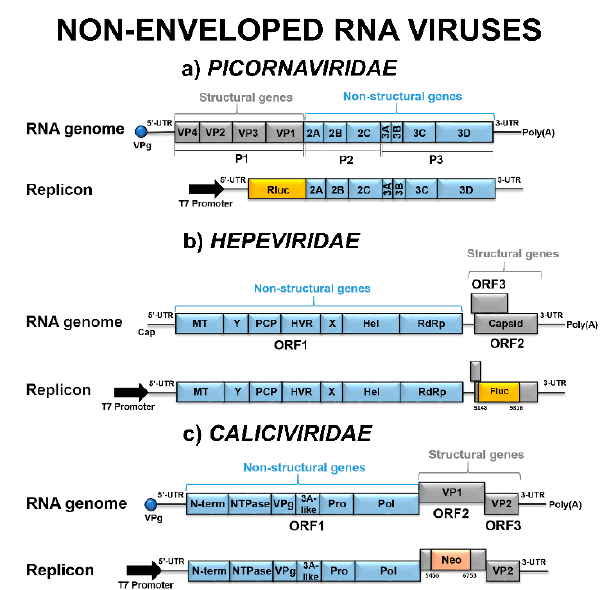
Figure 3. Schematic representation of non-enveloped RNA viruses’ genomes and subgenomic replicon systems. ( a ) Picornaviridae replicon based on the construct described by [83] for the Poliovirus (PV). The capsid coding P1 region is replaced by the Rluc gene. ( b ) Hepeviridae replicon based on the construct described by [84] for the Hepatitis E virus (HEV). The ORF2 capsid gene is disrupted with the Fluc gene (nucleotides 5148 to 5816). ( c ) Caliciviridae replicon based on the construct described by [85] for the Norwalk virus (NV). The Neo gene was engineered into the 5 ′ -end region of the ORF2 so that the expressed product would contain the first 33 aa of the NV VP1 fused in frame with neomycin phosphotransferase.